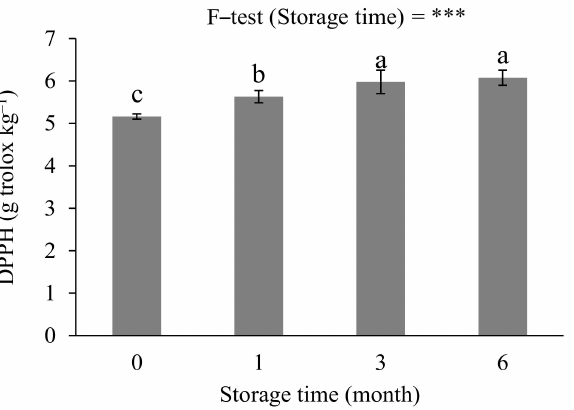
Figure 4. DPPH activity of the high-antioxidant capacity KAK variety stored in vacuum- and non- vacuum-sealed packages. Data were analyzed by F-tests (*** p < 0.001). Different letters indicate least significant differences ( p < 0.05). The values of DPPH activity are expressed as mean ± SD ( n =